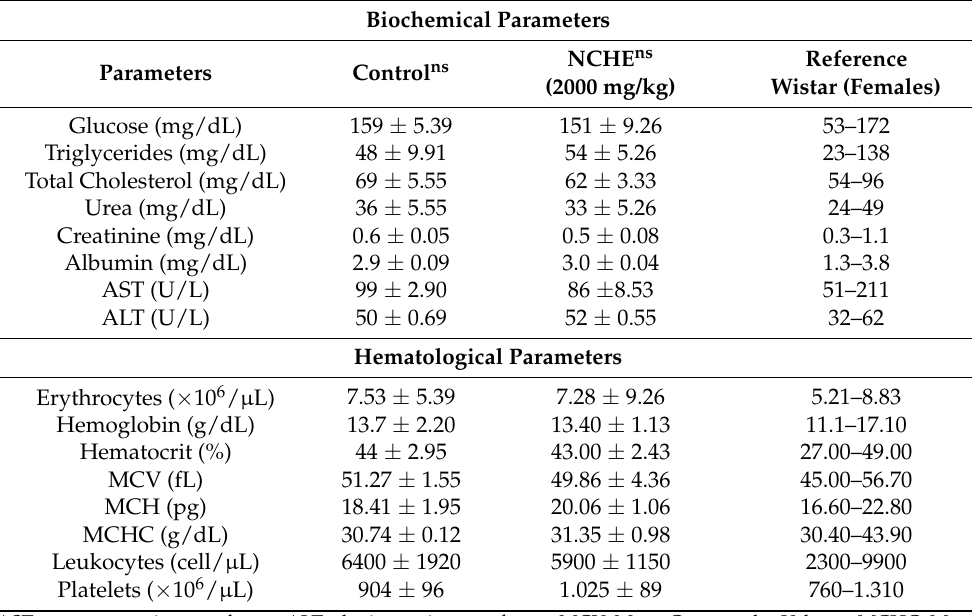
Table 3. Biochemical and hematological parameters of female rats treated with a single oral dose (2000 mg/kg) of Nopalea cochenillifera hydroethanolic extract (NCHE).